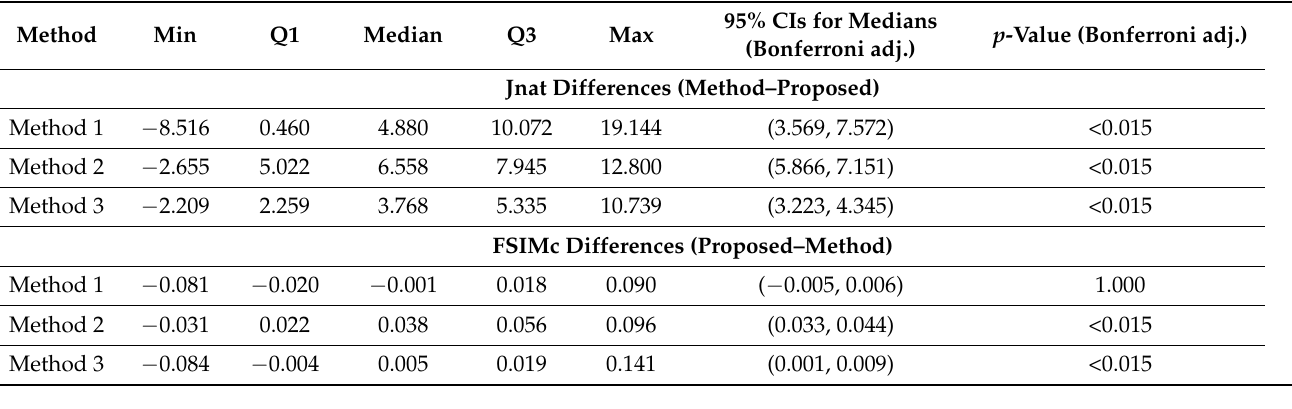
Table 7. Descriptive statistics of the observed Jnat and FSIMc differences between the three competing methods and the proposed method for the deuteranopia case considering the McGill’s Flowers and Fruits data sets (in total 195 images).